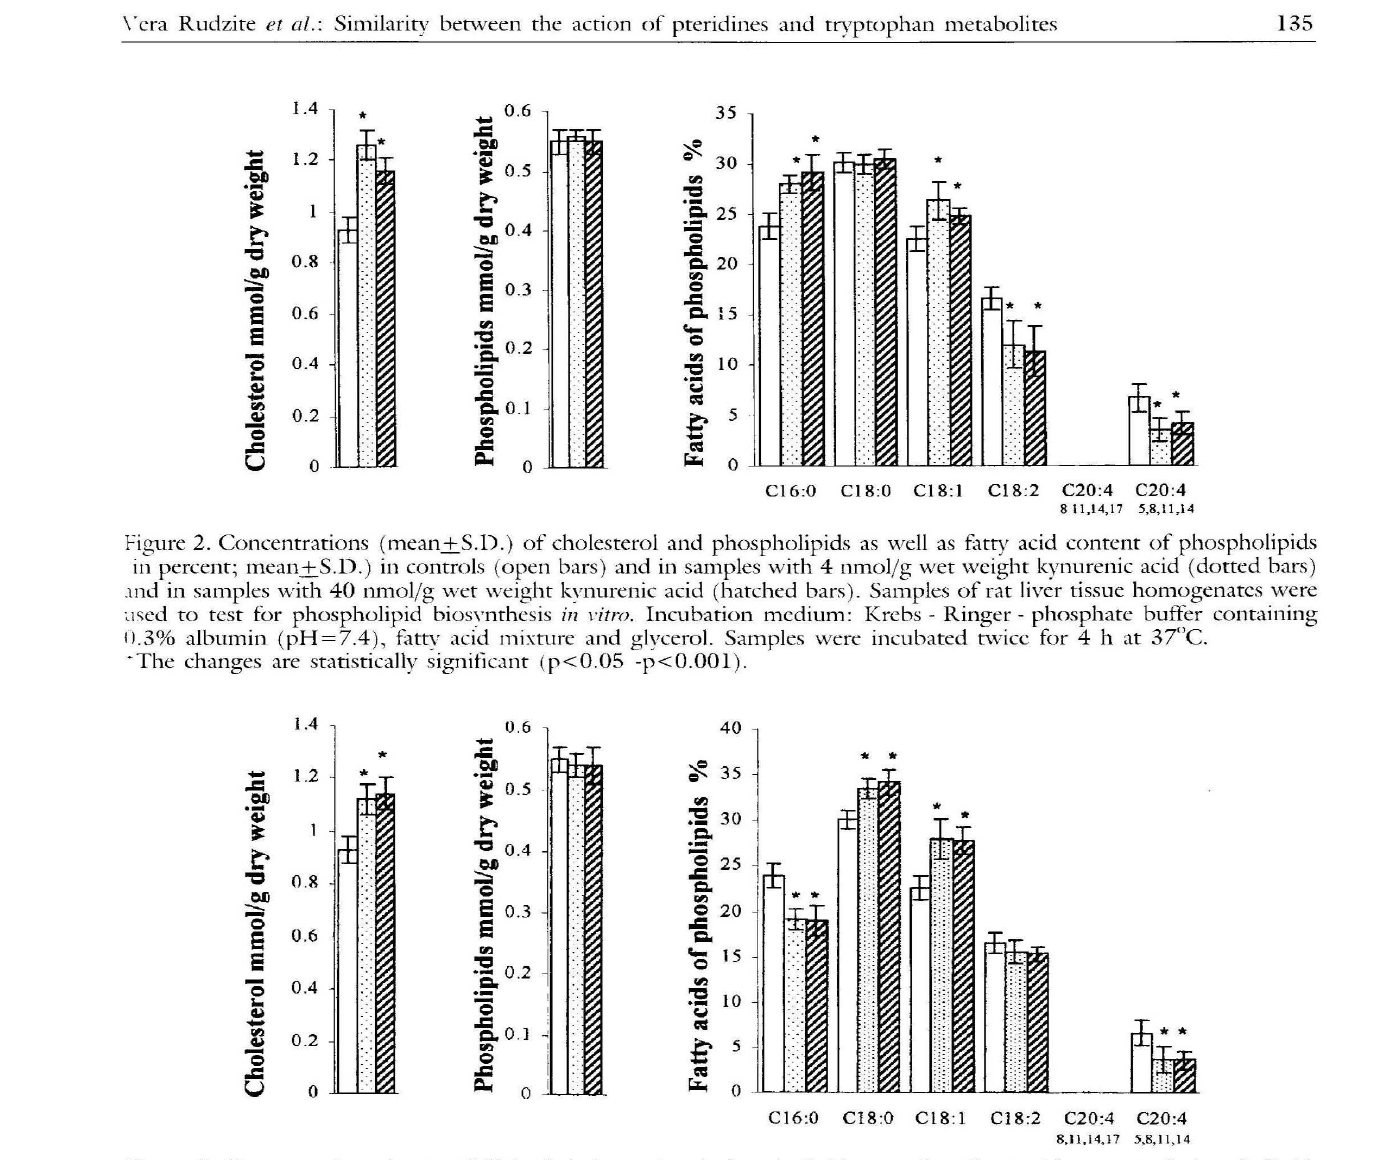
Figure 3 pictures changes of phospholipid